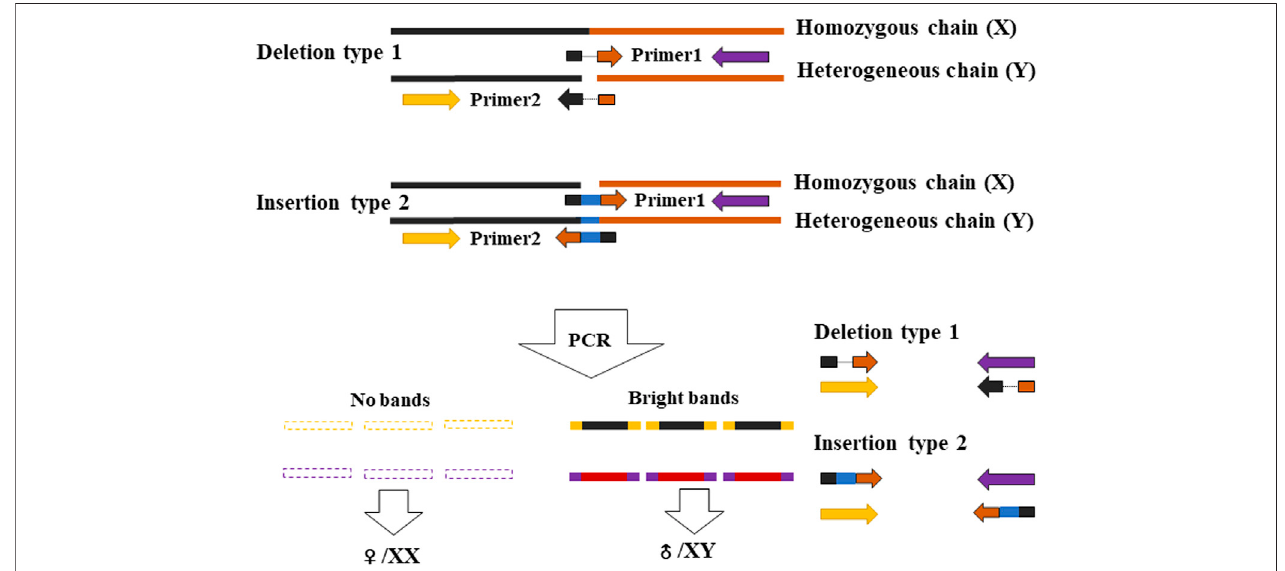
FIGURE 2 | Schematic diagram of design principles of the sex-speci fi c marker primers.